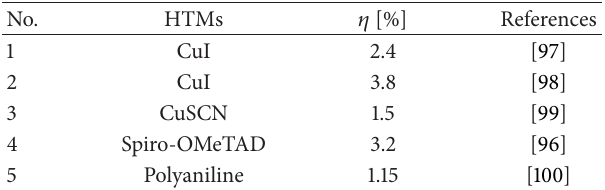
increased to 3.2% by improving dye adsorption by the pres- Table 5: Performance of different HTMs in